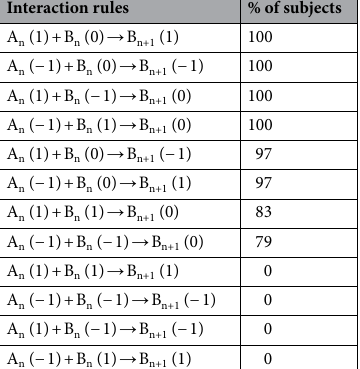
Interaction rules % of